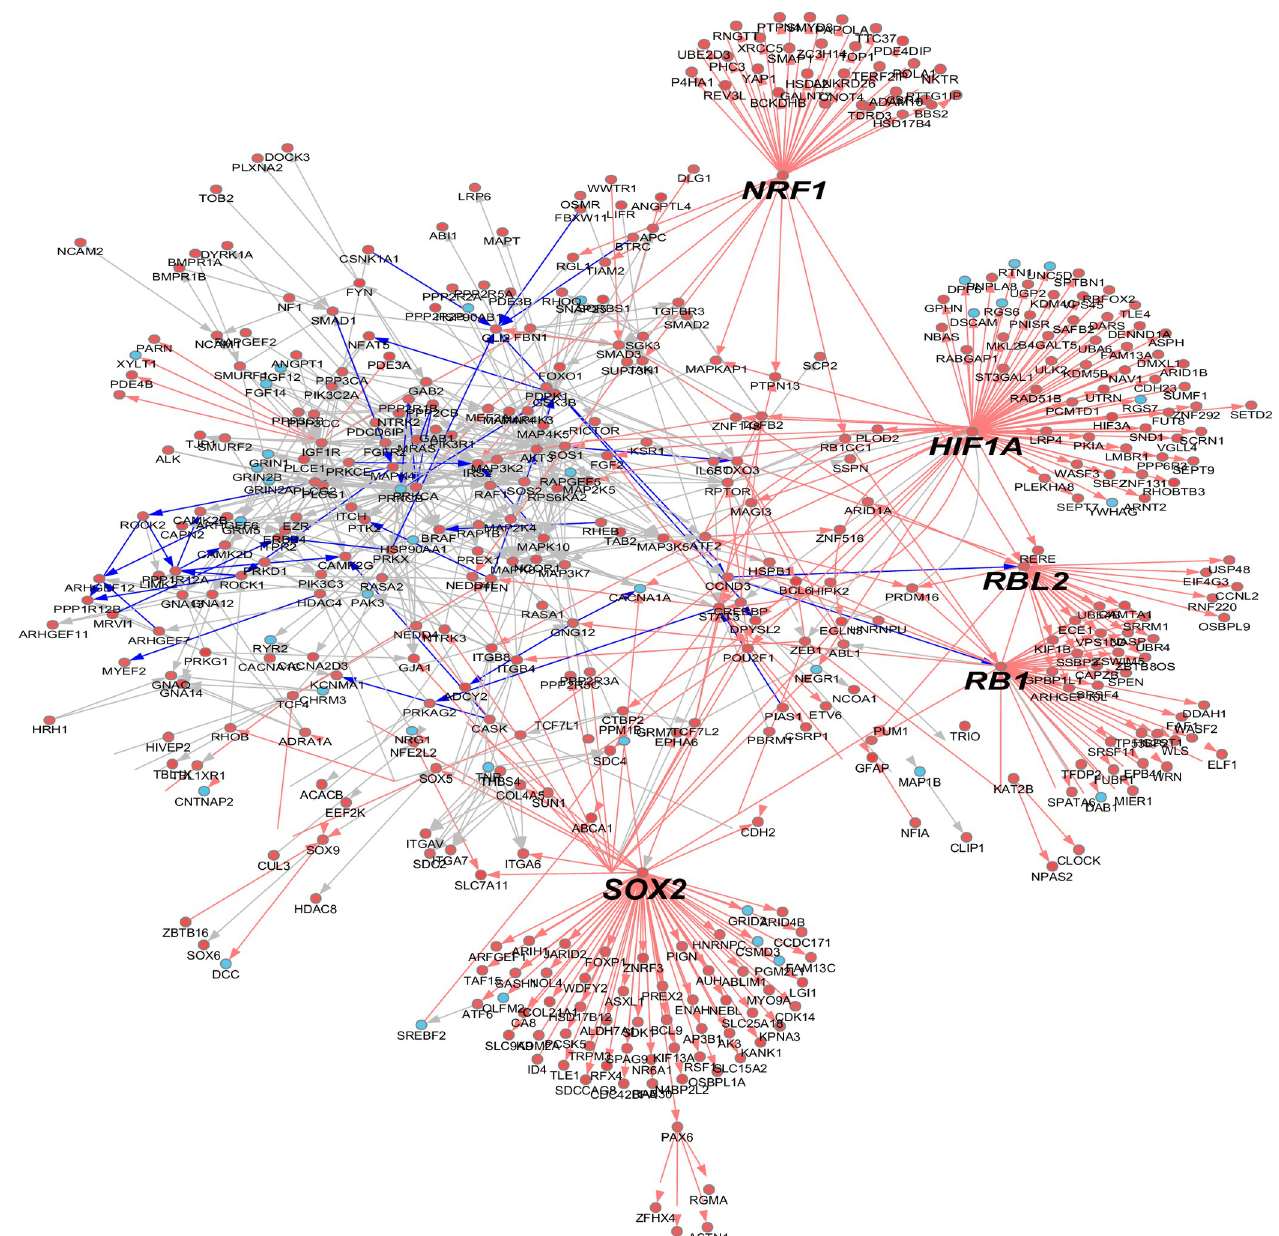
Fig 4. Gene network. A) gene network of genes found as differentially expressed between AD to control samples. The most highly abundant macroglia and oligodendrocyte gene markers gene names are shown. For example: SOX2 , NRF1 , HIF1A RBL2 , RB1 . Blue: Down regulation, red up regulation. Each node corresponds to a gene. The edges: Blue–down regulated gene, red marks up regulated genes. Top column names are marked with the gene groups marker genes names. Distance method: Euclidian. The analysis was done in AltAnalyze program. B) Pericyte gene network. Noted are, PBX1 HIF1A and STAT3 .